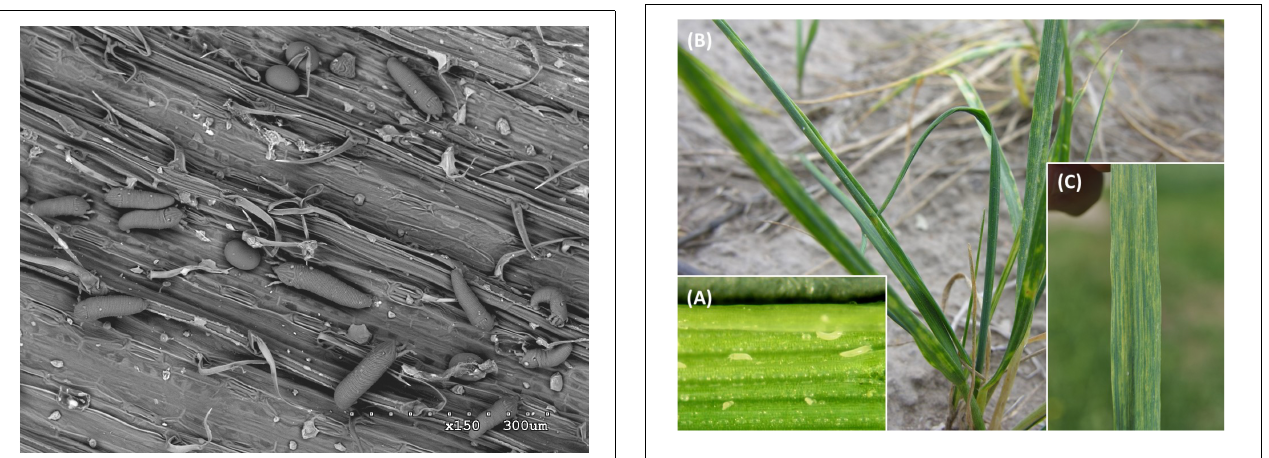
FIGURE 2 | Wheat curl mite (WCM) and WSMV symptoms: (A) specimens of WCM on a wheat leaf; (B) leaf curls caused by WCM; and (C) WSMV symptoms on wheat